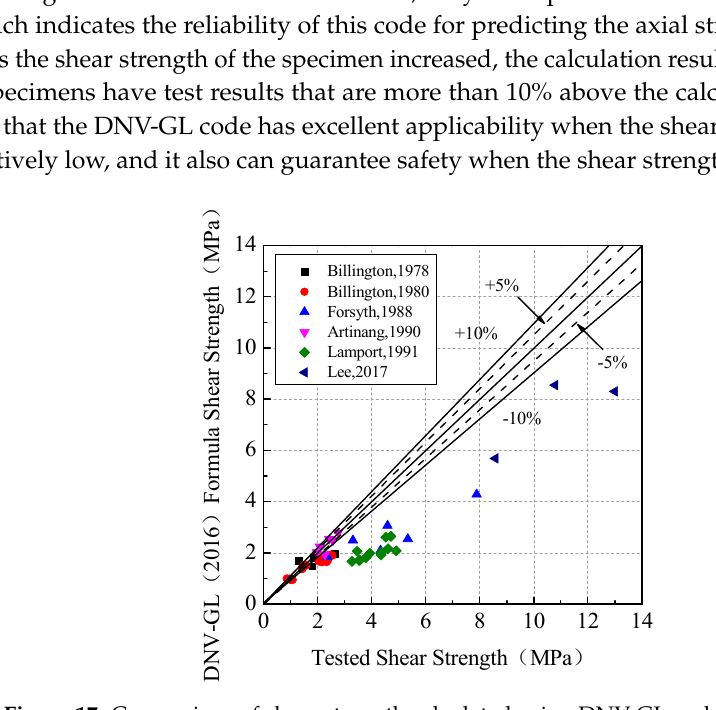
Figure 17. Comparison of shear strength calculated using DNV-GL and tested results.